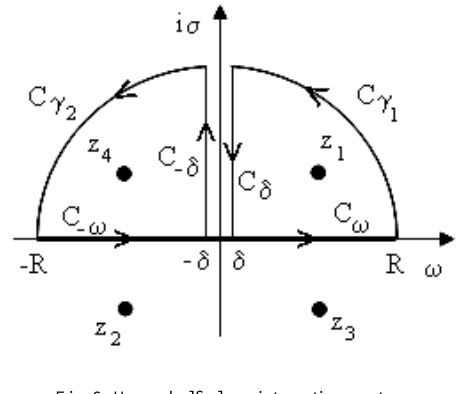
Fig. 6. Upper half-plane integration